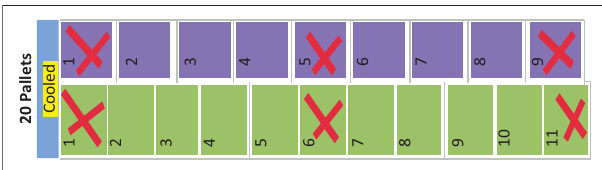
FIGURE 3: Pallet positions within